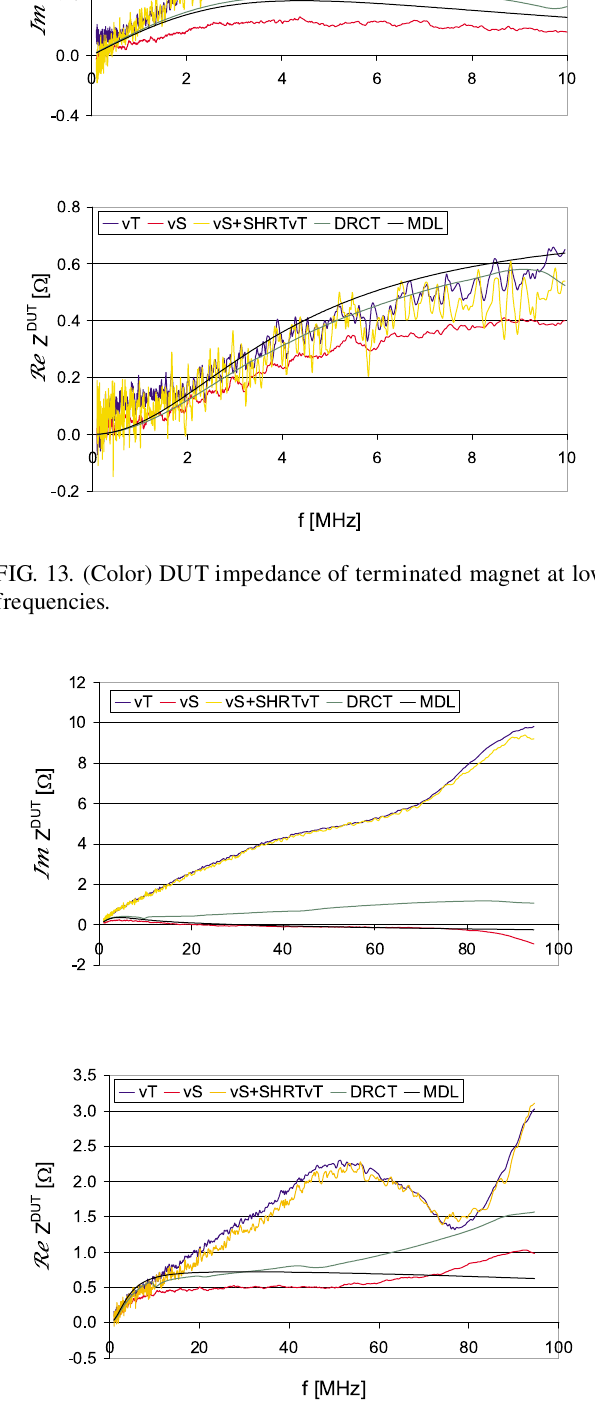
FIG. 14. (Color) Measured DUT impedance of magnet with 25 (cid:16) termination.